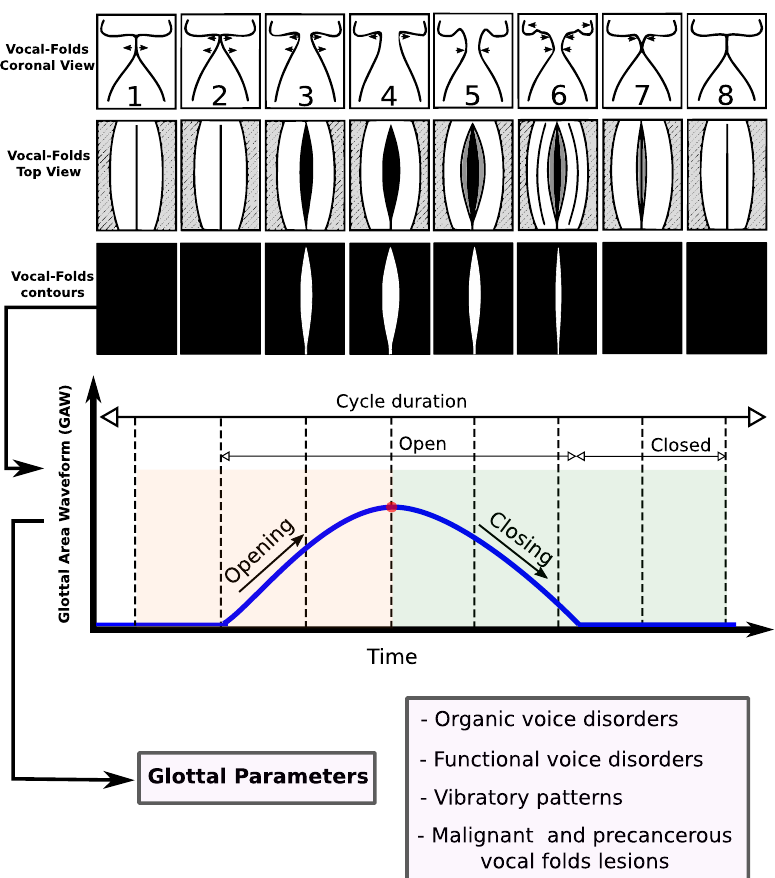
Figure 4. Graphical illustration of the procedure followed to extract glottal features from vocal folds motion during phonation. First row shows the coronal view of the vocal folds; second row represents the top view of the vocal folds obtained from the Laryngeal Videostroboscopy (VS)or HSV recording; third row depicts the glottal segmentation; and fourth row illustrates the glottal area waveform (GAW)